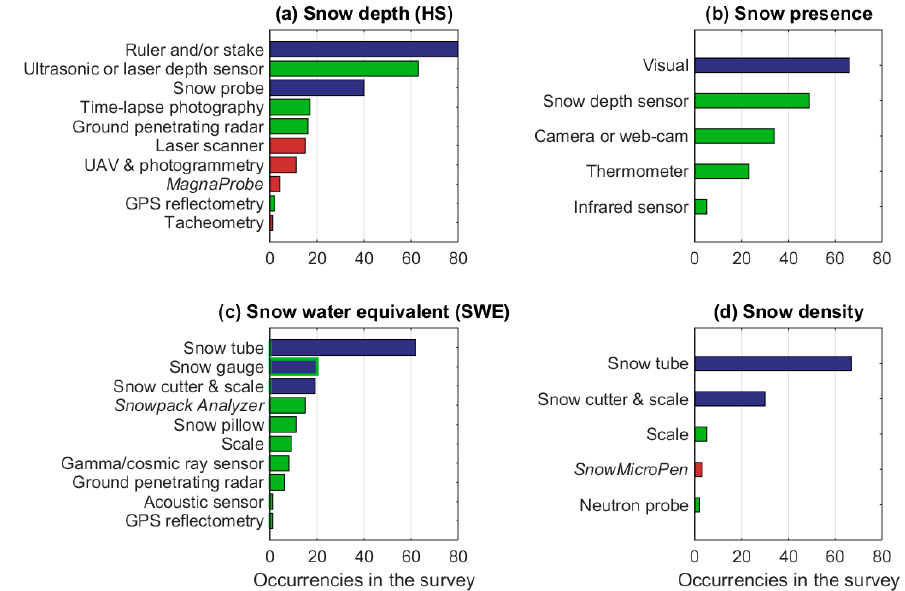
Figure 6. Occurrences of the applied instruments to measure snow macrophysical properties, such as snow depth ( a ), snow presence ( b ), snow water equivalent ( c ), and snow density ( d ). Different colours denote manual instrument without electronics (blue), manual instrument with electronics (red), manual instrument without electronic or fully automatic depending on the version of the instrument (blue with green contour), and fully automatic instrument (green).